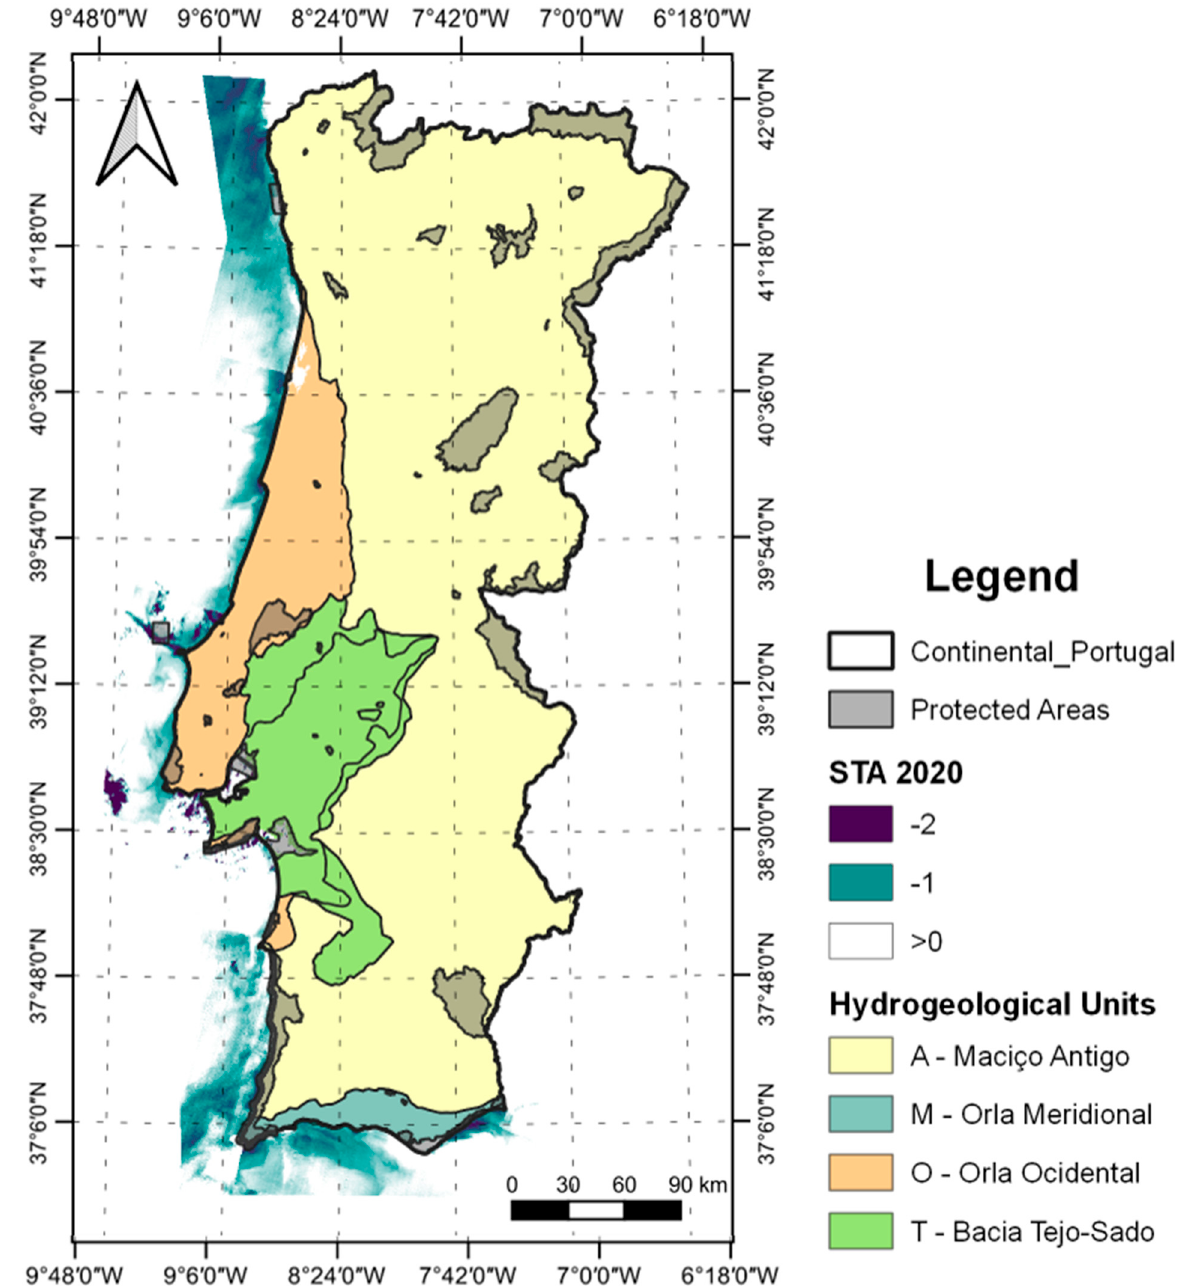
Figure 4. Negative standardized Temperature Anomalies (STA) in the coastal zone of Portugal. Negative STA indicates colder water assumed to potentially be groundwater discharge.